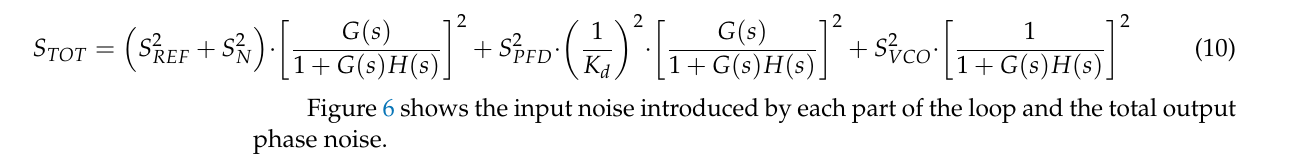
Table 4. Phase noise simulation results.